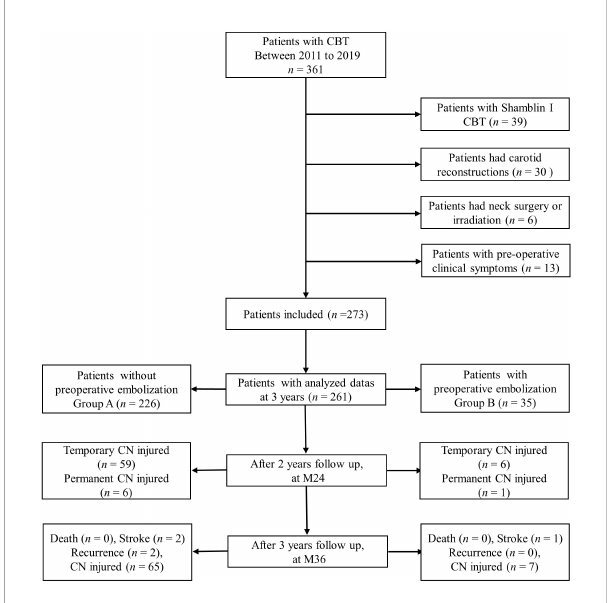
FIGURE 1 The fl ow diagram of this multicenter retrospective study for CBT patients with or without preoperative embolization after 3 years of follow-up. CBT, Carotid body tumor; CN, cranial